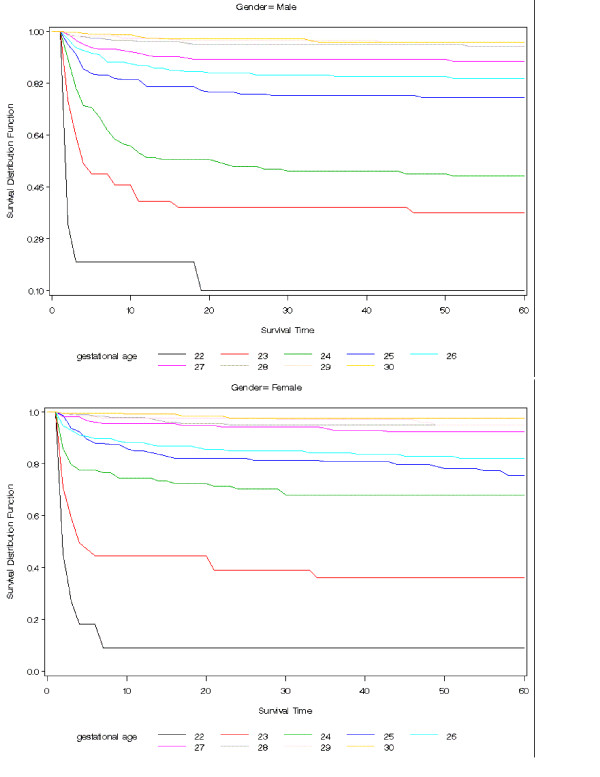
Actuarial survival curves stratified by gestation (weeks), by gender.